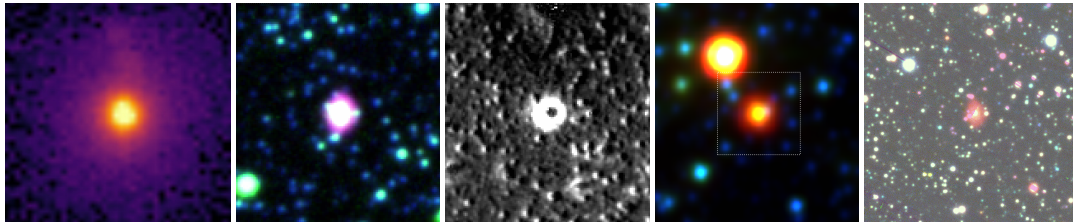
Figure 1. Examples images of Elliptical objects. From left to right: Elliptical galaxy from the Galaxy Zoo dataset [11]; Elliptical PNe in Optical images, H α “Quotient” images and infrared (“WISE432”) images; and high-resolution Optical Pan-STARRS